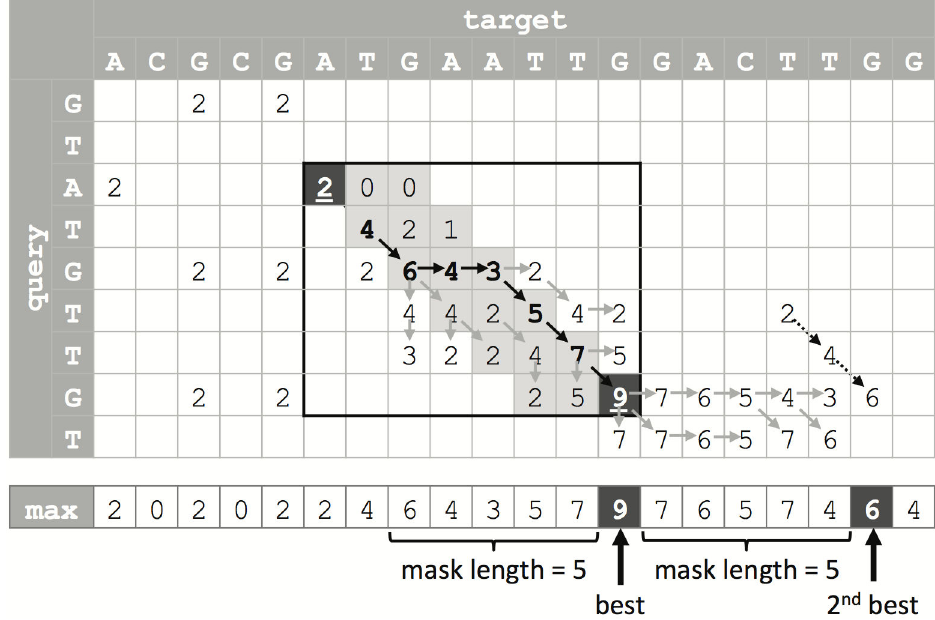
Figure 4. Illustration of alignment traceback and suboptimal alignment score determination. An example SW score matrix is shown (penalties for match, mismatch, gap open and extension are 2, -1, -2, and -1 respectively). The bottom row indicates the maximum score for each column. The algorithm locates the optimal alignment ending position (the black cell with score 9) using the array of maximum scores, and then traces back to the alignment start position (the black cell with score 2) by searching a much smaller, locally computed score matrix (circled by the black rectangle). Finally, a banded SW calculates the detailed alignment by searching the shaded sub-region. The scores connected by solid arrows belong to the optimal alignment. The max array records the largest score of each column. After the optimal alignment score (marked by “best”) is found, its neighborhood is masked, and the second largest score is reported outside the masked region (marked by 2nd best). The scores connected by dashed-line arrows trace the suboptimal alignment.